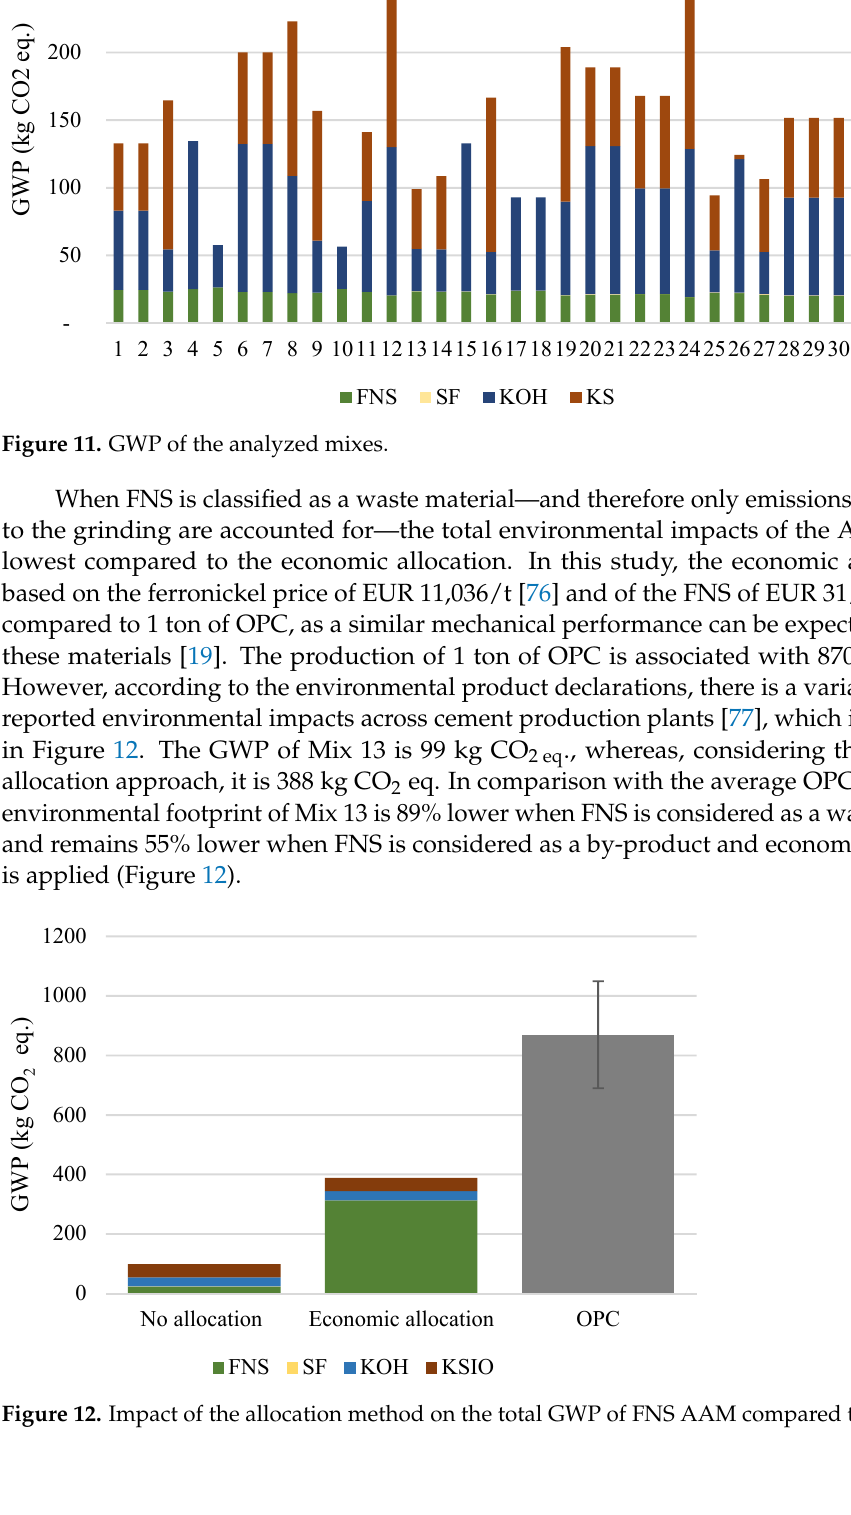
Figure 10. Correlation between cost and: ( a ) unheated flexural strength; ( b ) flexural strength after a high thermal load; ( c ) unheated compressive strength; ( d ) compressive strength after a high thermal load. For all samples, the water-to-binder ratio equals 0.176, and the tests occurred after 42 days of curing in ambient conditions, preventing moisture loss.